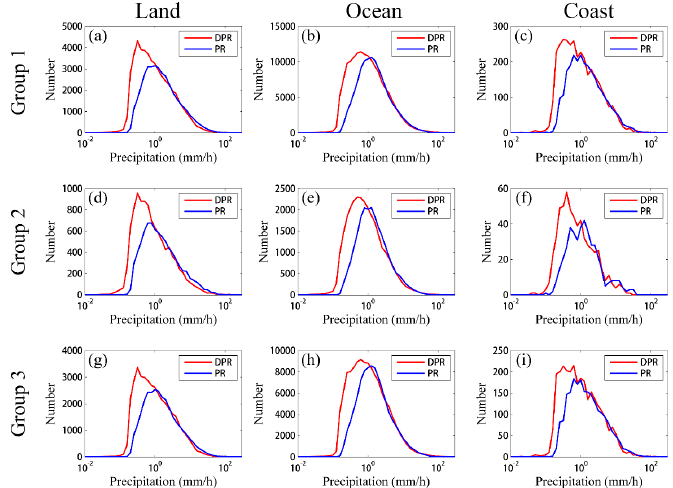
Figure 11. The frequency distributions for precipitation occurring over: ( a , d,g ) land; ( b , e,h ) ocean; and ( c , f,i ) coast, based on the coincident events. Panels ( a – c ) are based on Group 1; Panels ( d – f ) are based on Group 2; Panels ( g – i ) are based on Group 3 The coordinates in x -axis is exponential, ranging from 0.01 to 300 mm/h and divided into 50 bins.